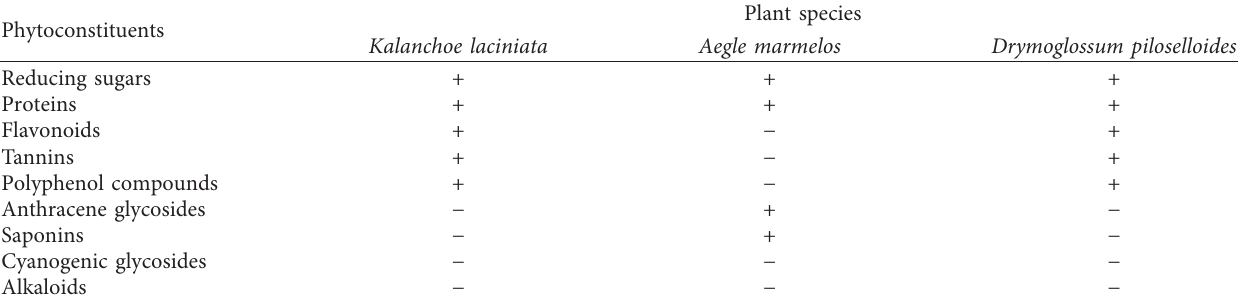
Table 1: Phytoconstituents identified by the qualitative assays in the three plants under